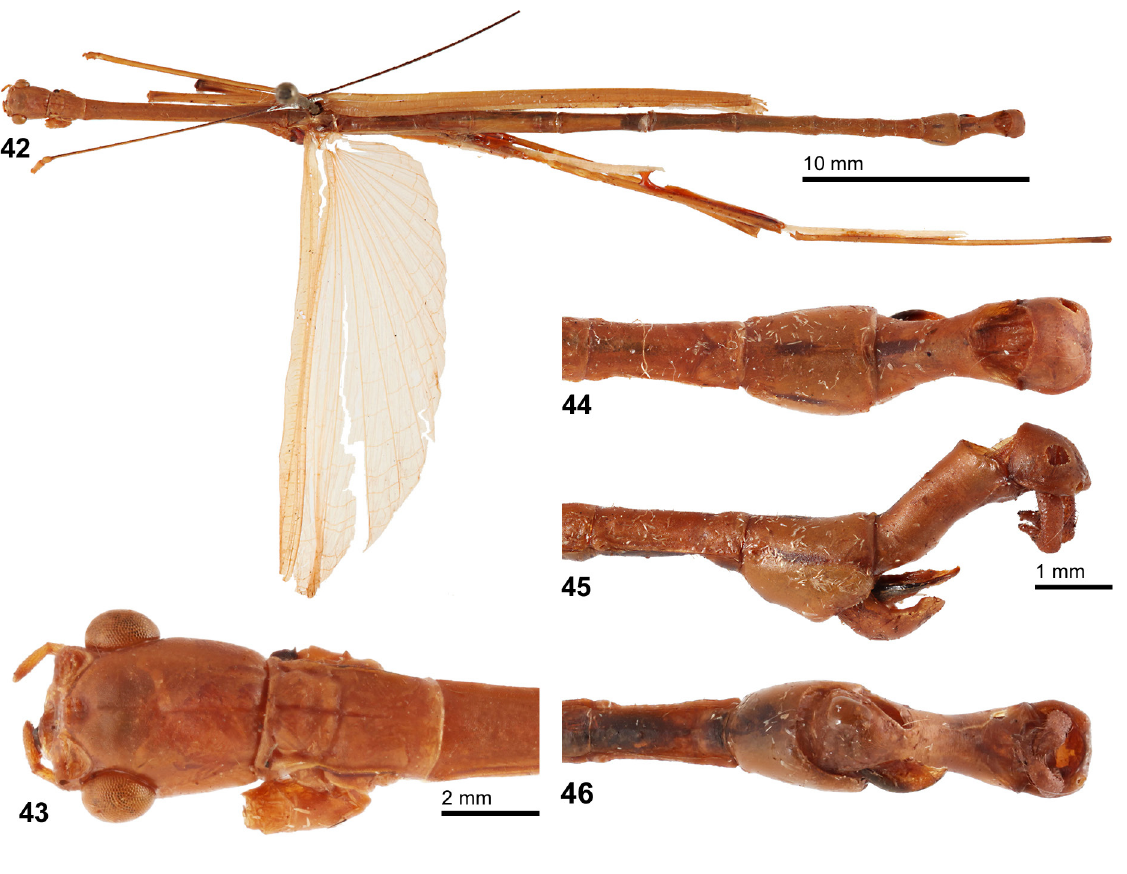
Figs 42–46. Phantasca heteronemia (Günther, 1940). Holotype, ♂. 42 . Habitus, dorsal view. 43 . Head and pronotum, dorsal view. 44 . Apex of abdomen, dorsal view. 45 . Apex of abdomen, lateral view. 46 . Apex of abdomen, ventral